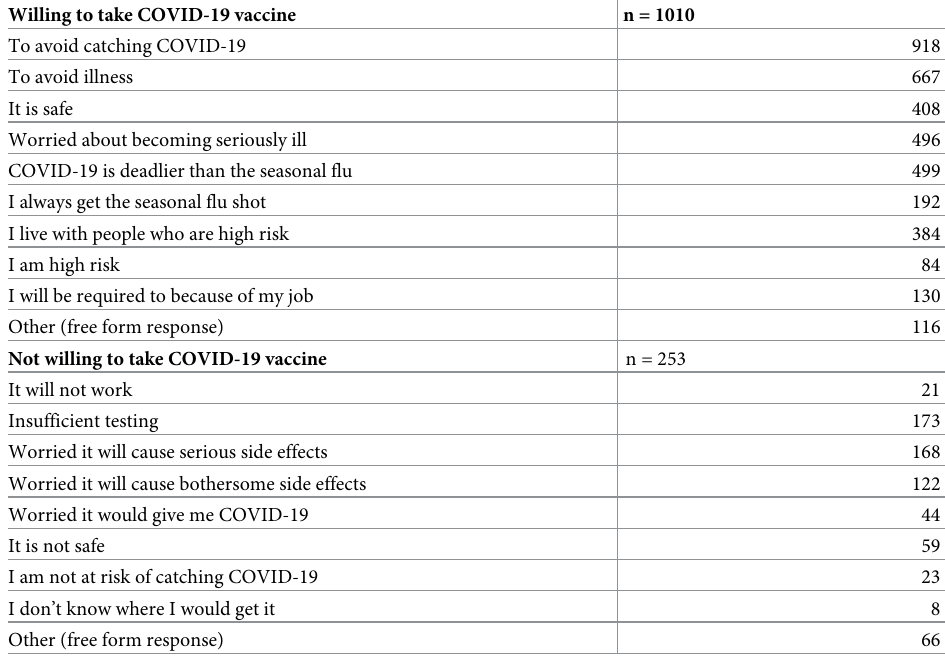
Table 6. Reasons for accepting or not accepting the vaccine (September/October survey). Willing to take COVID-19 vaccine n = 1010 To avoid catching